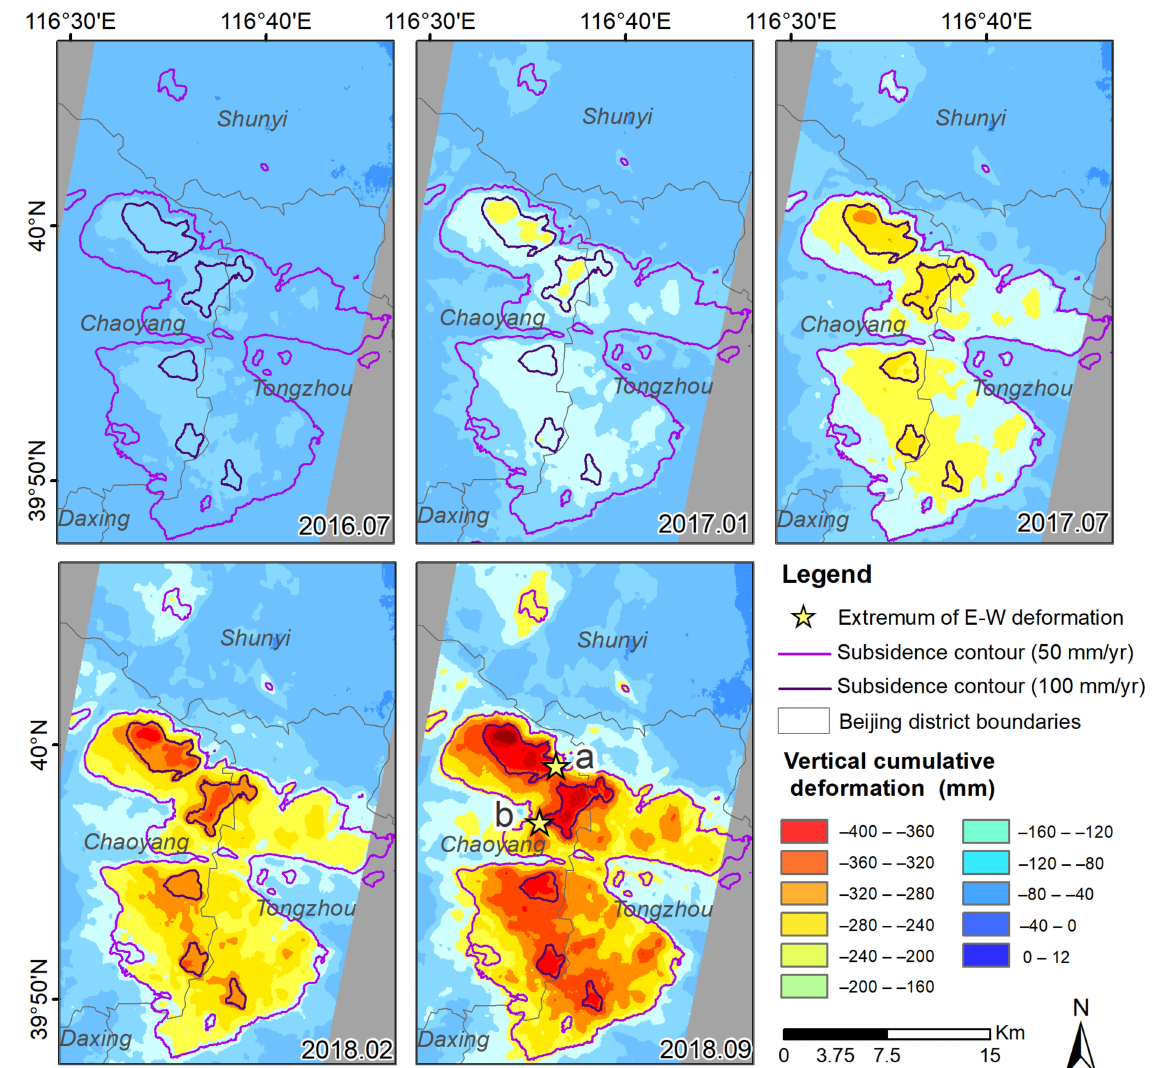
Figure 9. Time series maps showing the vertical cumulative displacement. (a: Extremum of west horizontal displacement; b: Extremum of east horizontal